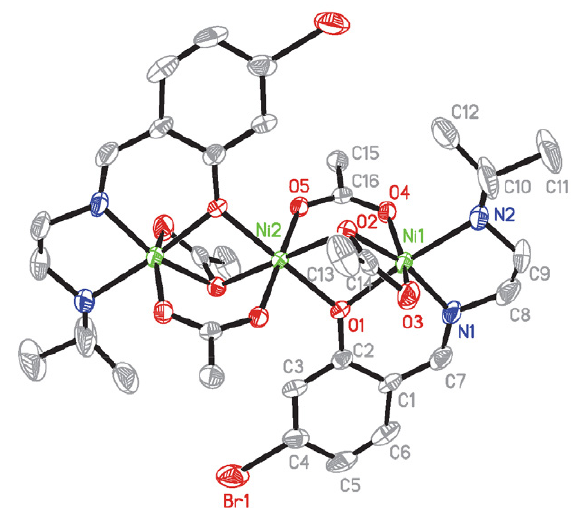
Figure 2. ORTEP diagram of complex 2 with thermal ellipsoids at 30% probability level. Selected bond lengths and angles are given in Table 2. Unlabeled atoms are related to the symmetry operation 1 – x , 1 – y , 1 – z